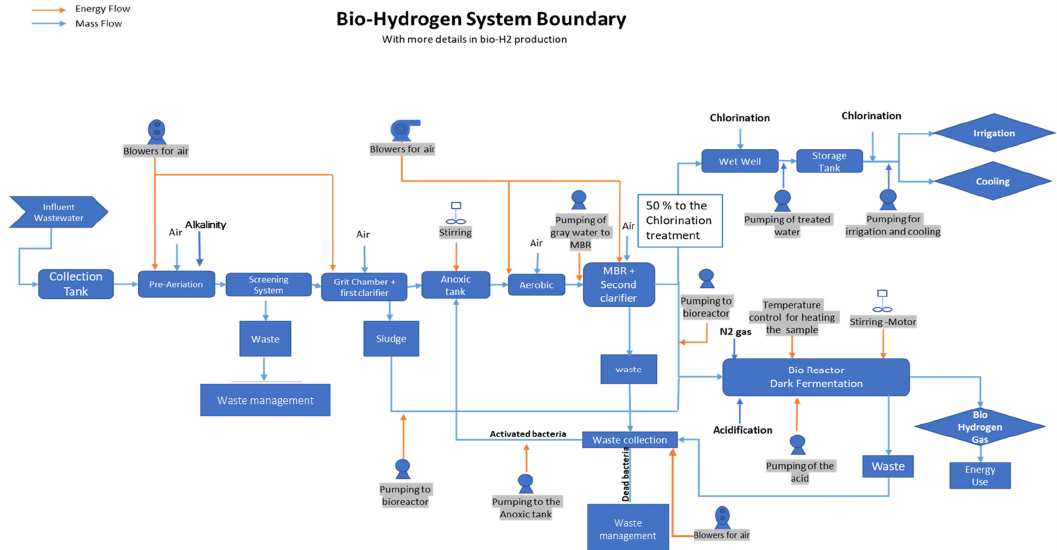
Figure 6. Mass- and energy-flow model.